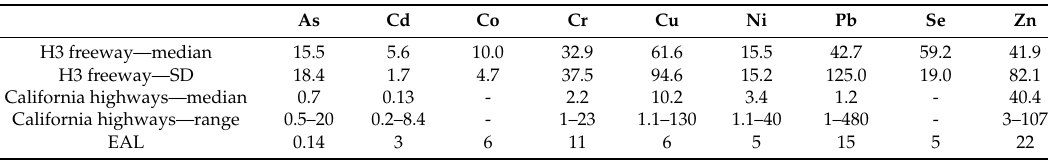
Table 2. Summary statistics (median and standard deviation (SD)) of observed dissolved metal concentrations ( µ g/L) in stormwater highway runoff from H3 collected on Halawa Valley Street. Median and range values are reported for California highway dataset [56]. EALs values refer for groundwater discharging to surface water